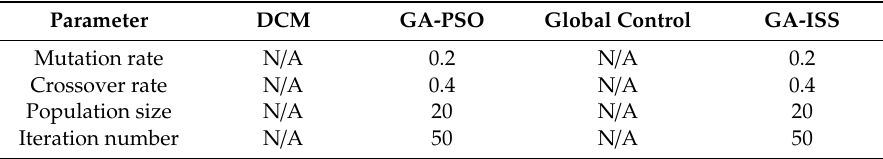
Table 6. Parameters of the algorithms utilized for group EV charging. Parameter DCM GA-PSO Global Control Mutation rate Crossover rate Population size Iteration